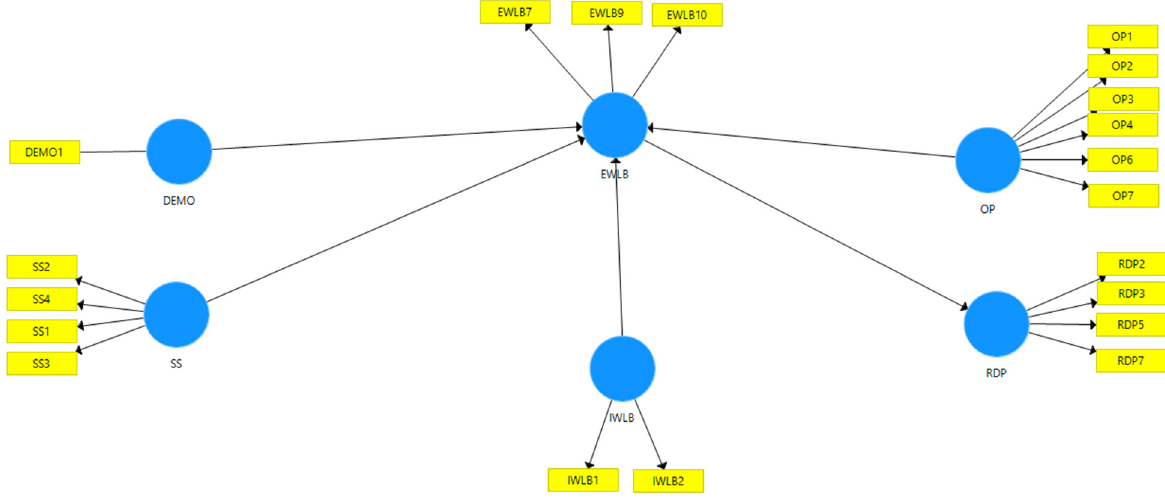
Figure 2. Structural model.